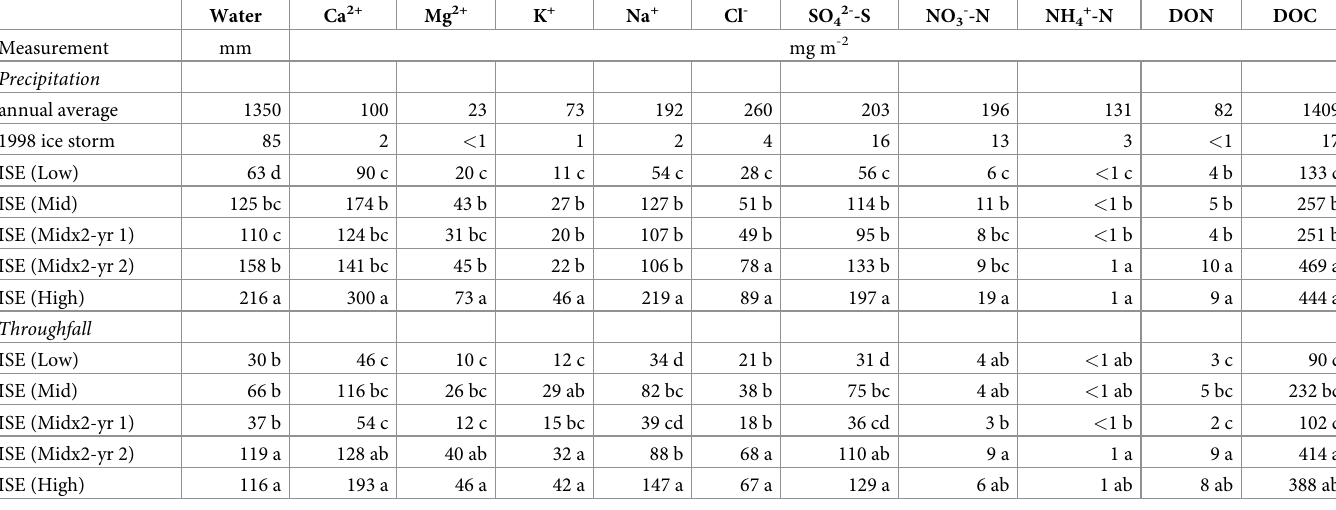
treatments (2017), 9 (Plot 1) and 42 (Plot 8) percent of the water sprayed onto plots was retained by the canopy as ice (Table 1). The two methods for measuring ice accretion were in close agreement for smaller treat- ments ( < 10 mm) with few icicles. Specifically, ice accretion measured by calipers was 111 and Table 3. Volume (mm) and chemistry (mg m -2 ) of precipitation and throughfall for different levels of treatment in the ice storm experiment as compared to mean annual precipitation (2012–2016) and the ice storm of 1998 in the reference watershed (W6) at the Hubbard Brook Experimental Forest. Water Ca 2+ Mg 2+ K + Na + Cl - SO 42- -S NO 3- -N NH 4+ -N DON DOC Measurement mm mg m